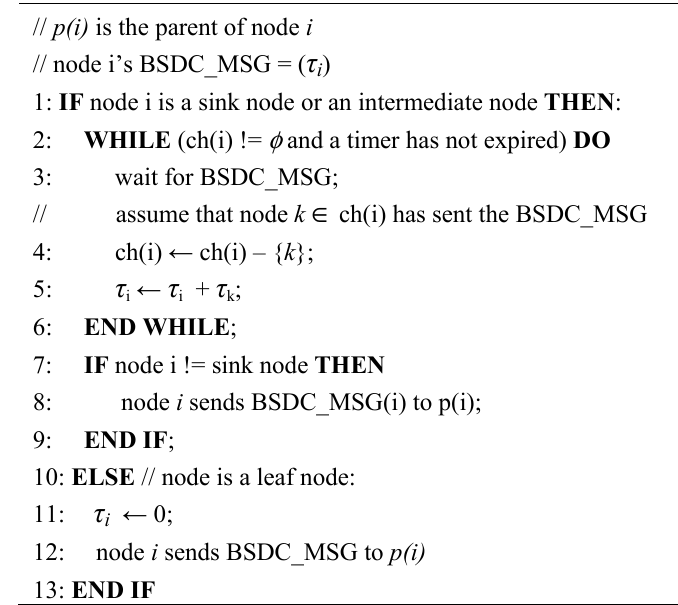
Figure 3. BSD calculation